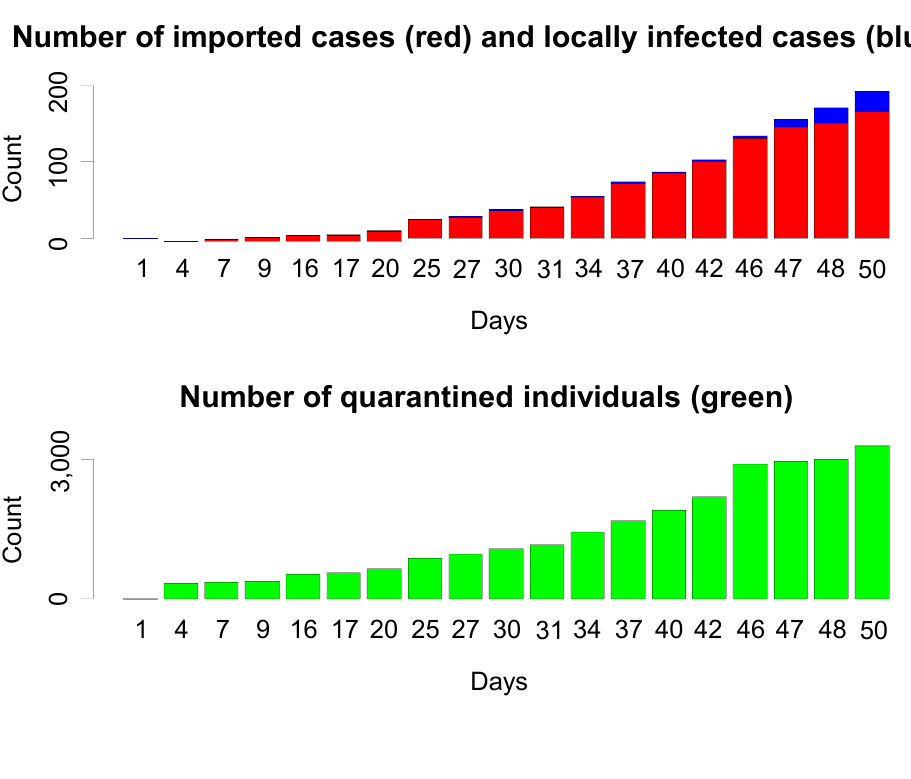
H1N1 pandemic, and quarantined individuals in Beijing during the mandatory quarantine enforced from 16 May (day 1) to 4 July 2009 (day